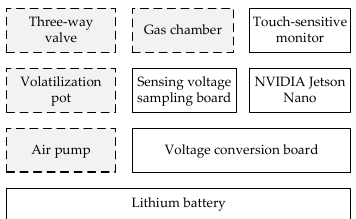
Figure 2. The structure block diagram of SMUENOSEv2.